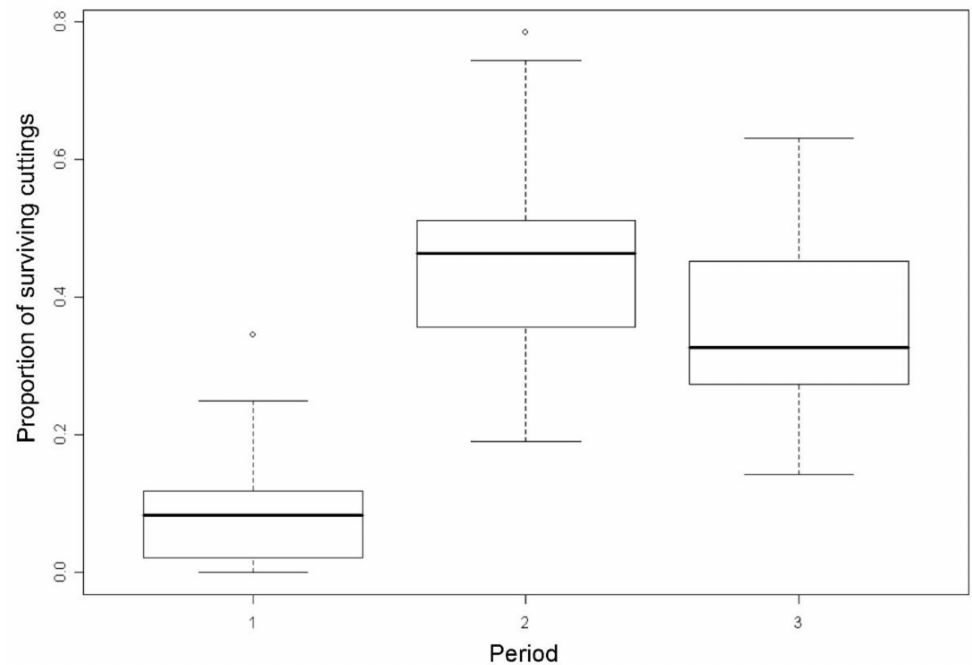
Figure 6. Box plot of the proportions of surviving cuttings from the total number of cuttings in relation to the cutting collection date. The horizontal line in each box represents the median, the hinges represent the 25th and 75th percentiles, the whiskers represent 1.5 times the interquartile range and open circles represent values outside this